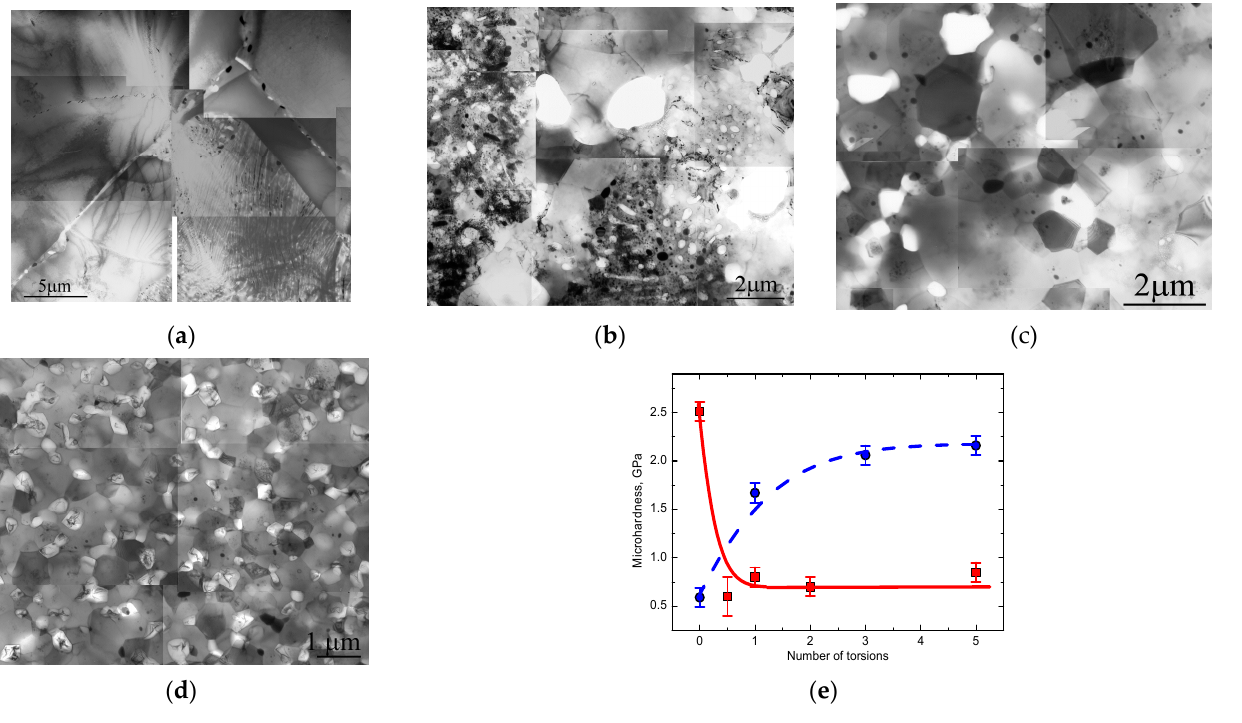
Figure 3. ( a – d ) Bright field transmission electron microscopy (TEM) micrographs of the Al–30% Zn alloy in the initial state ( a ) and after HPT: n = 0 ( b ), n = 0.5 ( c ) and n = 5 ( d ). ( e ) Vickers microhardness plotted vs. number of torsions for Al–30 wt.% Zn (solid red squares) [8] and Al–8.8 wt.% Mg alloys (solid blue circles) [25]. Reprinted with permission from ref. [8]. Copyright 2012 Elsevier.